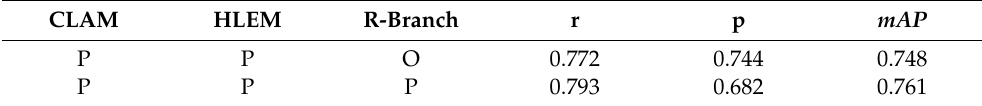
Table 13. Effectiveness of R-branch when the other two modules are added.